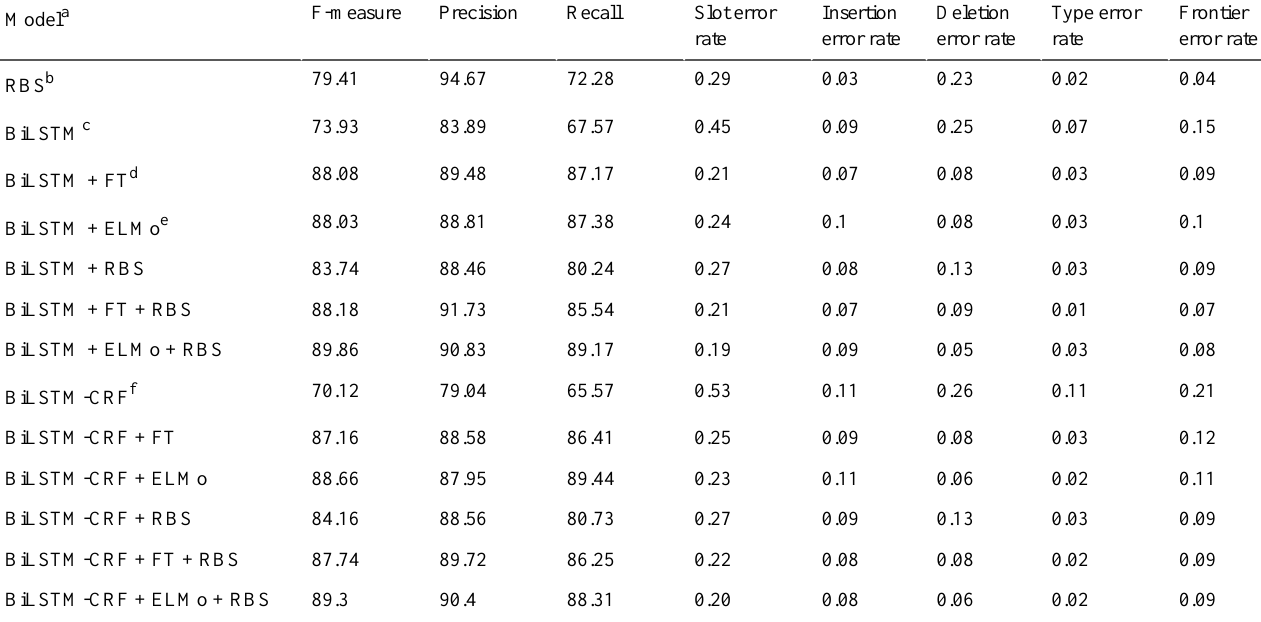
Table 3. Overall medication component information predictions metrics by models.